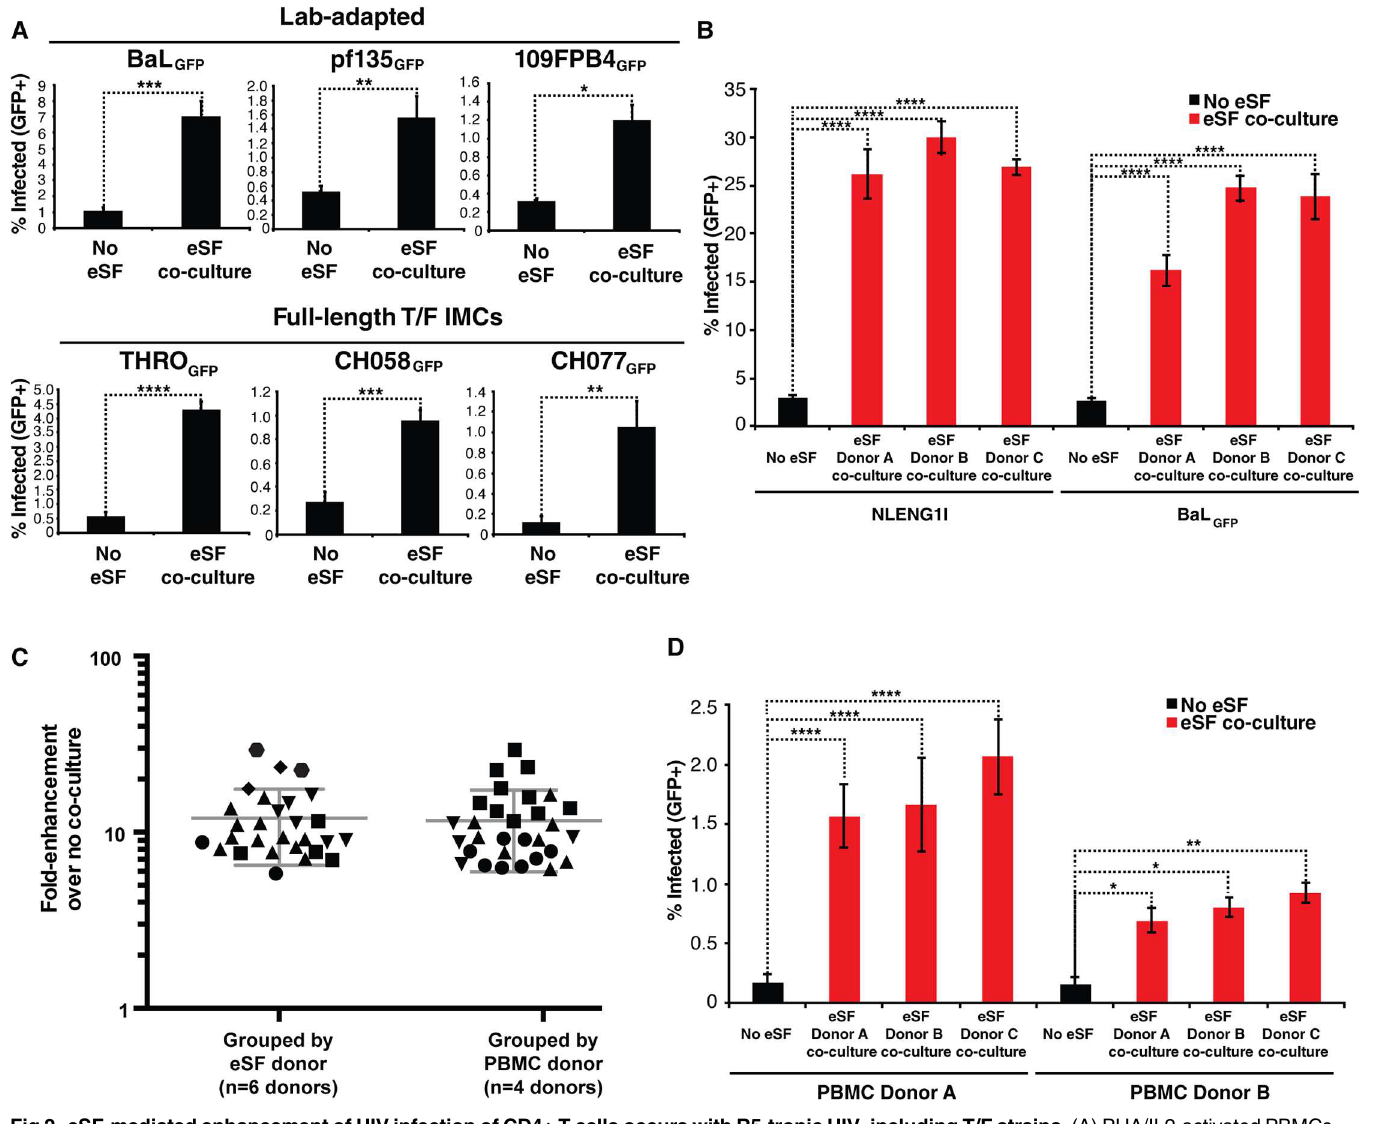
Fig 2. eSF-mediated enhancement of HIV infection of CD4+ T cells occurs with R5-tropic HIV, including T/F strains. (A) PHA/IL2-activated PBMCs cultured with or without eSF were infected with the indicatedR5-tropic HIV and monitoredby flow cytometry for infectionlevels 3 d later. Results are gated on live, singlet CD3+CD8- cells. * p < 0.05, ** p < 0.01, *** p < 0.001, **** p < 0.0001 (by 2-tailed t test). (B) PHA/IL2-activated PBMCs were infected with X4-tropic NLENG1I or R5-tropic BaL GFP in the absenceor presenceof eSF from 3 different donors, and monitored3 d later for levels of productiveinfection. Results are gated on live, singletCD3+CD8-cells. **** p < 0.0001 relative to no coculturein a group-wise comparison(one-way analysisof variance with a Bonferroni posttest). (C) Fold-enhancement of BaL GFP infection of PBMCs when comparing infectionrates in the presenceversus absenceof eSF. Shownon the left are fold-enhancements mediatedby six different donorsof eSF, where each shapecorrespondsto one eSF donor (mean: 12-fold). Shownon the right are fold- enhancements mediatedby four different donors of PBMCs, where each shape corresponds to one PBMC donor (mean: 12-fold). (D) PHA/IL2-activated PBMCs were infected with a T/F full-lengthGFP-IMC THRO GFP in the absenceor presence of eSF from 3 different donors, and monitored 3 d later for levels of productiveinfection. Results are gated on live, singletCD3+CD8-cells. ** p < 0.01, ** p < 0.01, **** p < 0.0001 relative to no coculture in a group-wise comparison(one-way analysisof variance with a Bonferroni